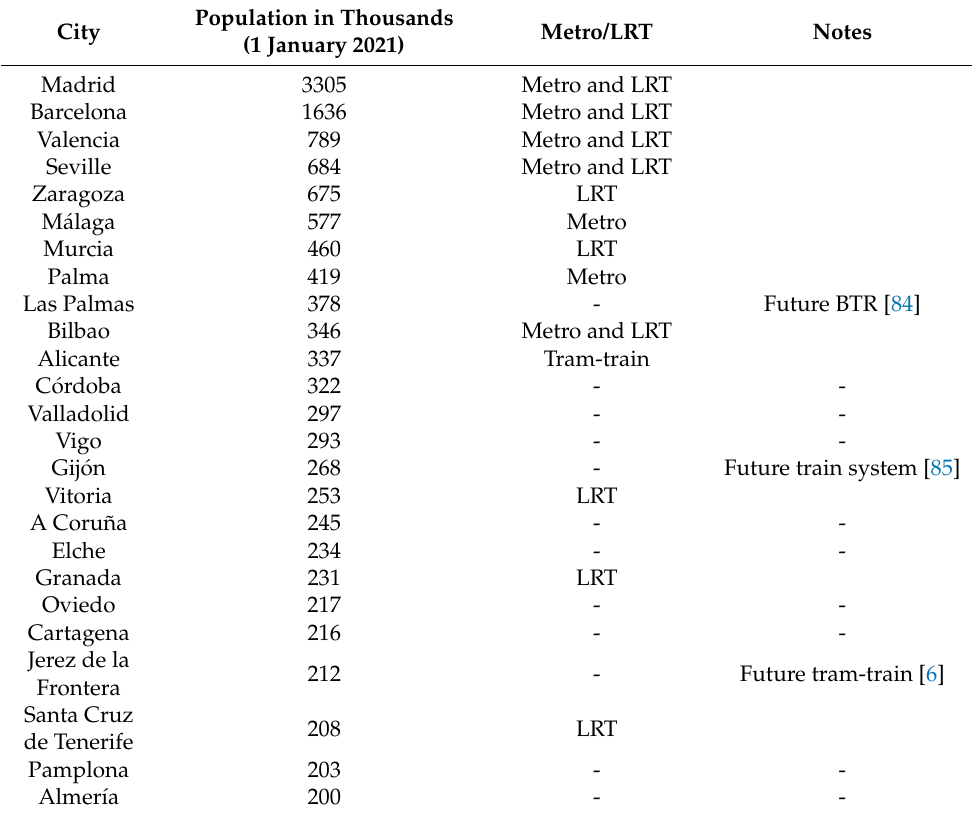
Table 5. Existence of metro and/or LRT in the main Spanish cities (municipalities which are part of a metropolis already cited are not